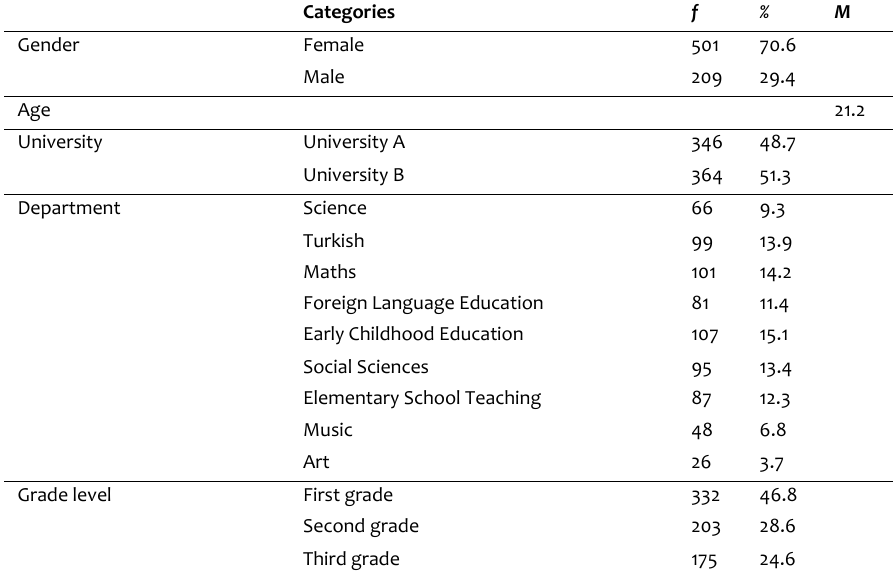
Table 1. Demographic Characteristics of the